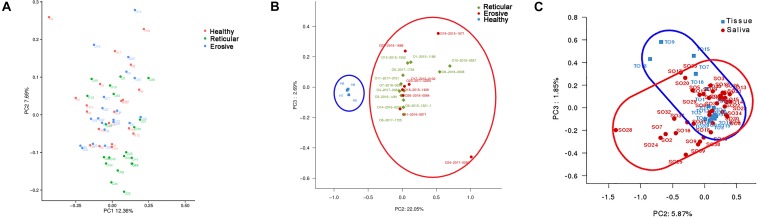
Principal component analysis (PCA) of saliva and tissue microbiota based on the weighted unifrac distance matrix. (A) Each point represents reticular OLP (green circle), erosive OLP (blue circle), and healthy controls (red circle) for each saliva sample. PC1 explained 12.36% of the variation, and PC2 explained 7.69% of the variation. (B) Each point on behalf reticular OLP (green diamond), erosive OLP (red circle), and healthy controls (blue square) for each tissue sample. PC2 explained 22.05% of the variation, and PC3 explained 2.69% of the variation. (C) Each point represents OLP saliva (red circle) and OLP tissue (blue square). PC2 explained 5.87% of the variation, and PC3 explained 1.85% of the variation. Each point represents a sample and is colored by sample type. The more similar samples are, the closer they are in the graph.